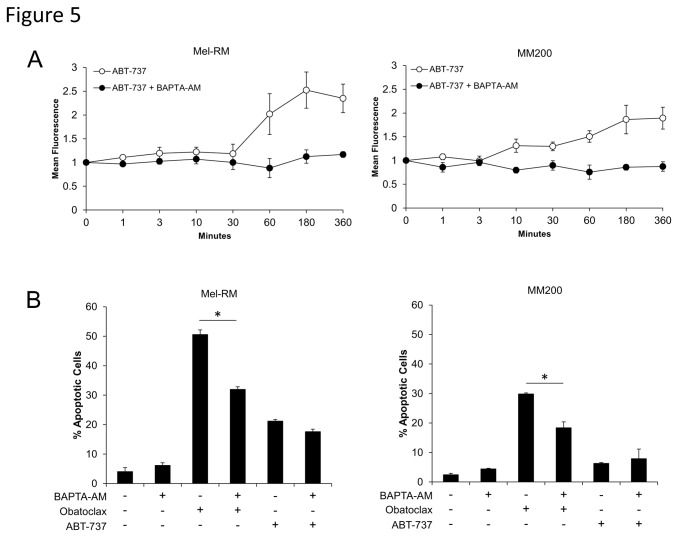
Induction of the UPR by ABT-737 is associated with increases in cytosolic Ca2+.A. Mel-RM and MM200 cells were treated with ABT-737 for indicated periods. Cells were collected, washed and incubated with 1µM of the fluorescent calcium probe Calcium Green-1 before analysis of calcium levels by flow cytometry. Obatoclax was unable to be used due to the inherent fluorescence of the compound. Increase in mean fluorescence is indicative of an increase in cytosolic calcium. Where indicated, cells were pretreated for 4 hours with 10µM of the calcium chelator BAPTA-AM before addition of ABT-737. Points, mean of three individual experiments; bars, SE.B. Mel-RM and MM200 cells were treated for 48 hours with Obatoclax (1µM) or ABT-737 (10µM) with or without a 4 hour pretreatnent with various doses of BAPTA-AM. Cells were then subjected to measurement of apoptosis by the propidium iodide method. Columns, mean of three individual experiments; bars, SE.